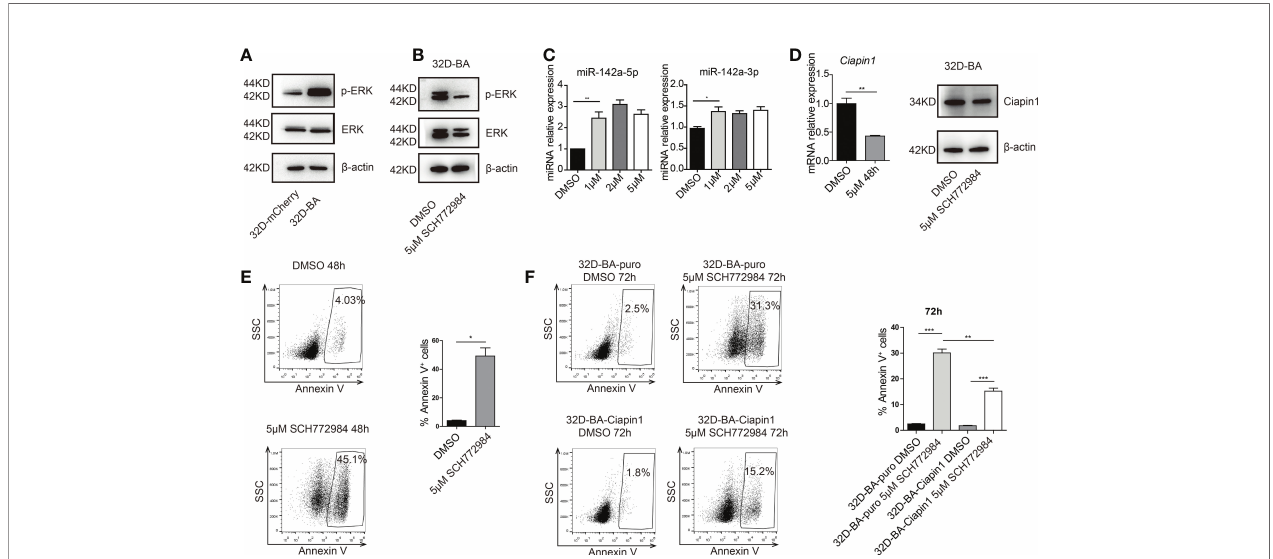
FIGURE 6 | Phosphorylated (P) ERK inhibited the expression of miR-142a in BA-harboring cells. (A) Western blot detection of total and p-ERK protein level in 32D- BA and 32D-mCherry cells. (B) The ERK inhibitor SCH772984 inhibited the p-ERK level in 32D-BA cell line. (C) qRT-PCR detection of miR-142a-5p and miR-142a- 3p level in 32D-BA cells with ERK inhibitor treatment. (D) qRT-PCR and Western blot analysis of Ciapin1 expression in 32D-BA cells with ERK inhibitor treatment. (E) Apoptosis analysis of 32D-BA cells with ERK inhibitor treatment. (F) Apoptosis analysis of 32D-BA-Ciapin1 cells with ERK inhibitor treatment. Results are mean ± SEM, *p < 0.05, **p < 0.01, ***p < 0.001 (C – F) was assessed by unpaired t